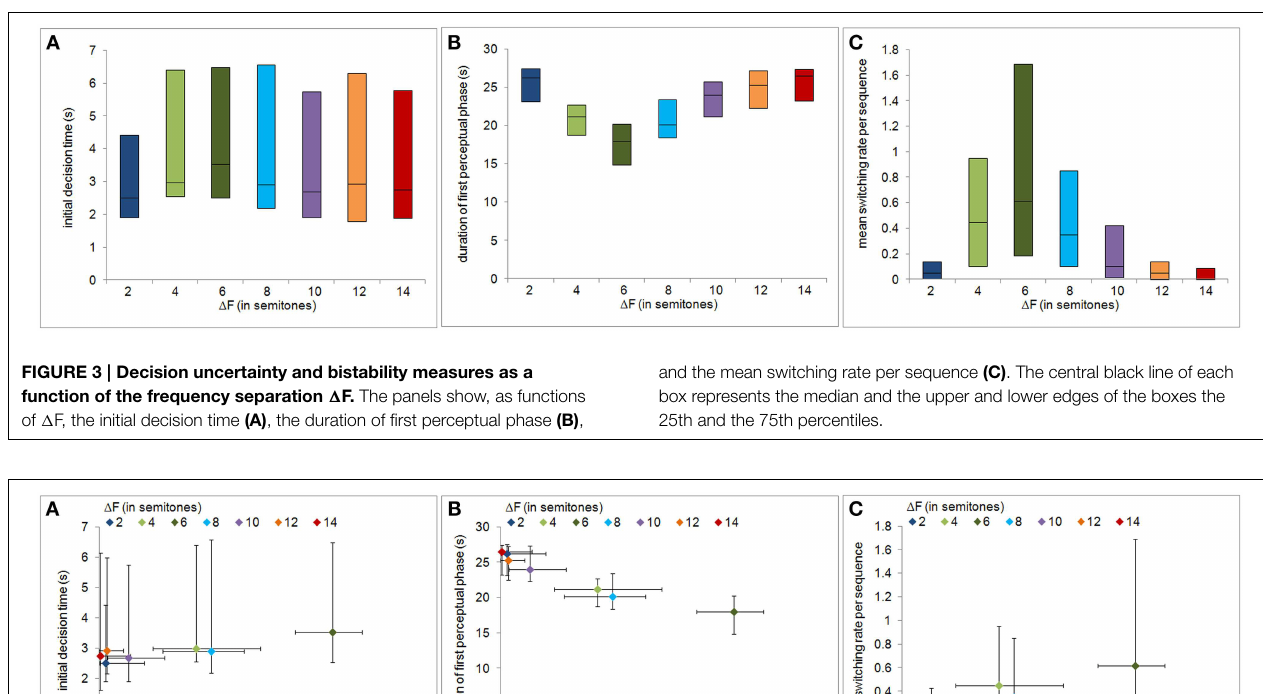
FIGURE 4 | Relation of perceptual ambiguity to decision uncertainty and bistability measures. The panels show, as functions of the ambiguity index, the initial decision time (A) , the duration of the first perceptual phase